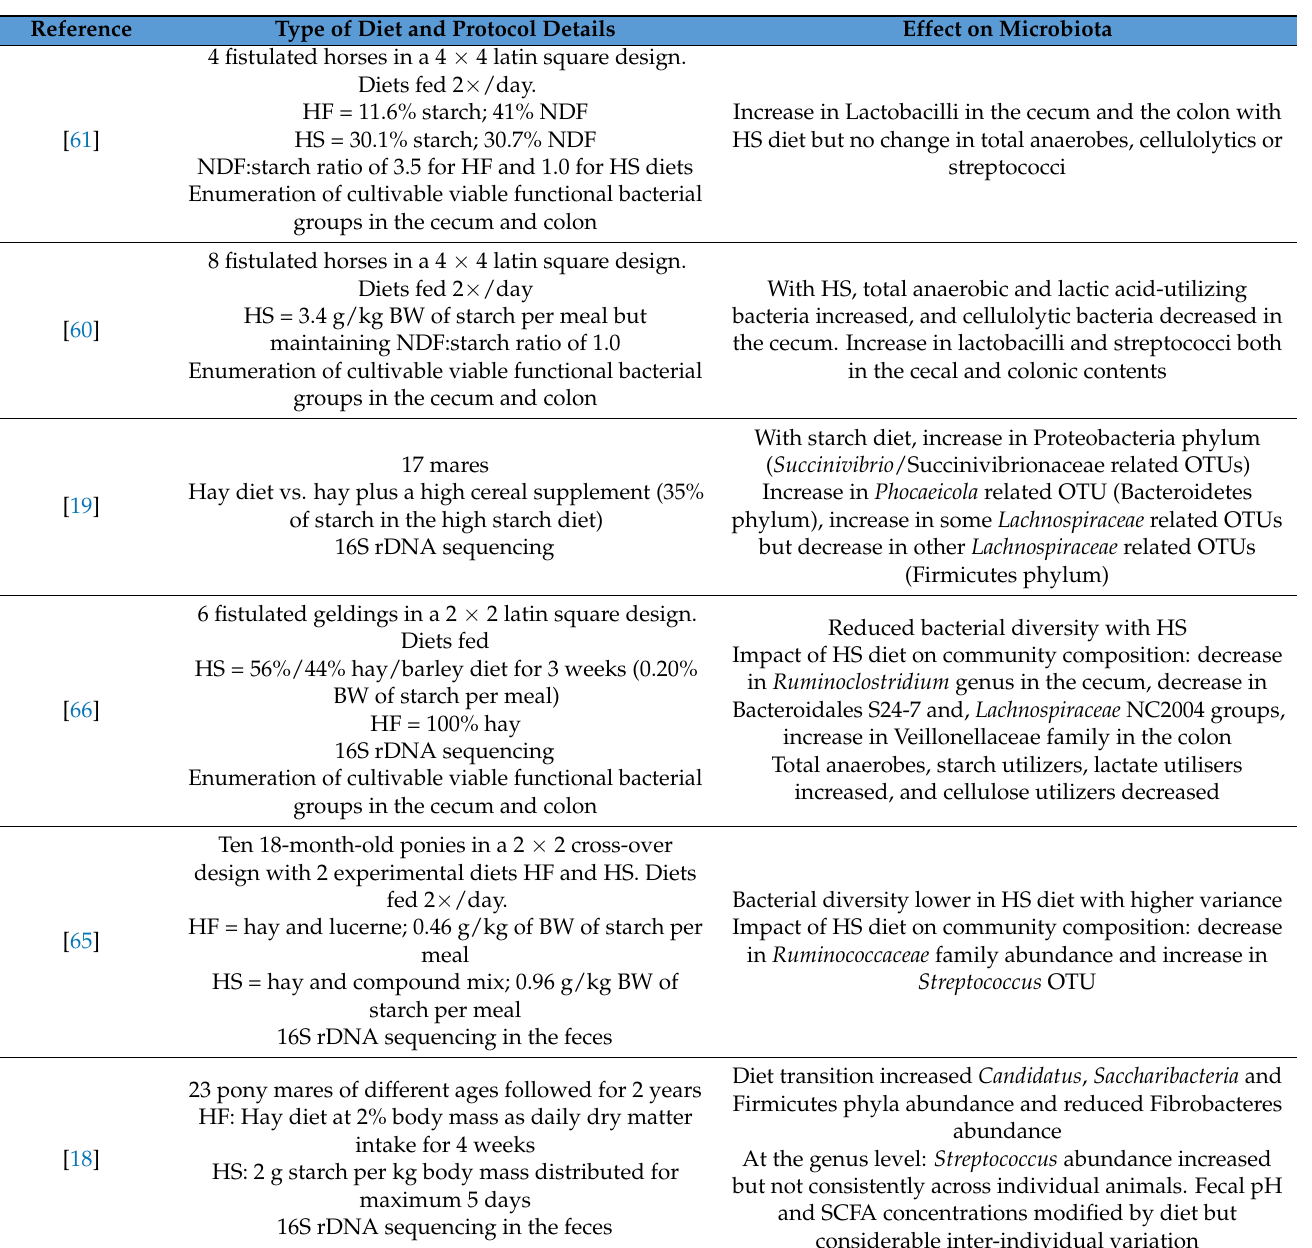
Table 1. Main effects of high starch diet on hindgut